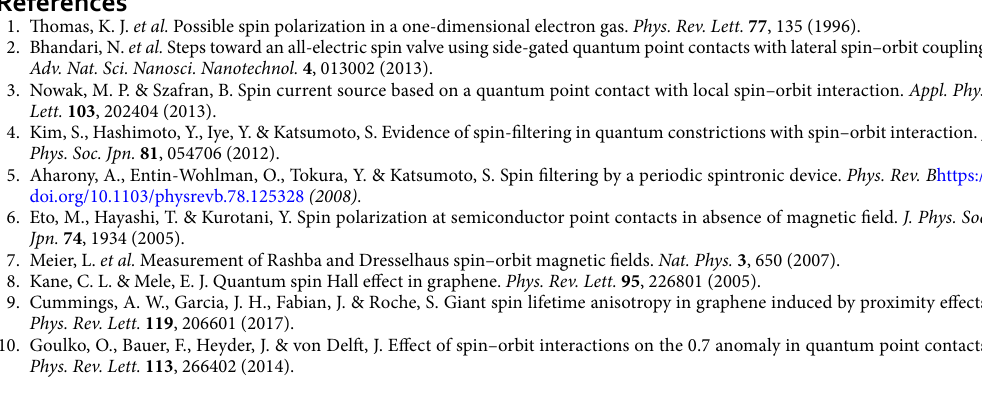
Figure 10. The splitting of the transconductance for parallel magnetic field B term active. For perpendicular B ( c ) in zigzag and ( d ) in armchair nanoribbon. The slope of the fitted line for ⊥ each split in the transconductance (see Fig. 9a, b) is equal to d (� V g ( B ))/ dB